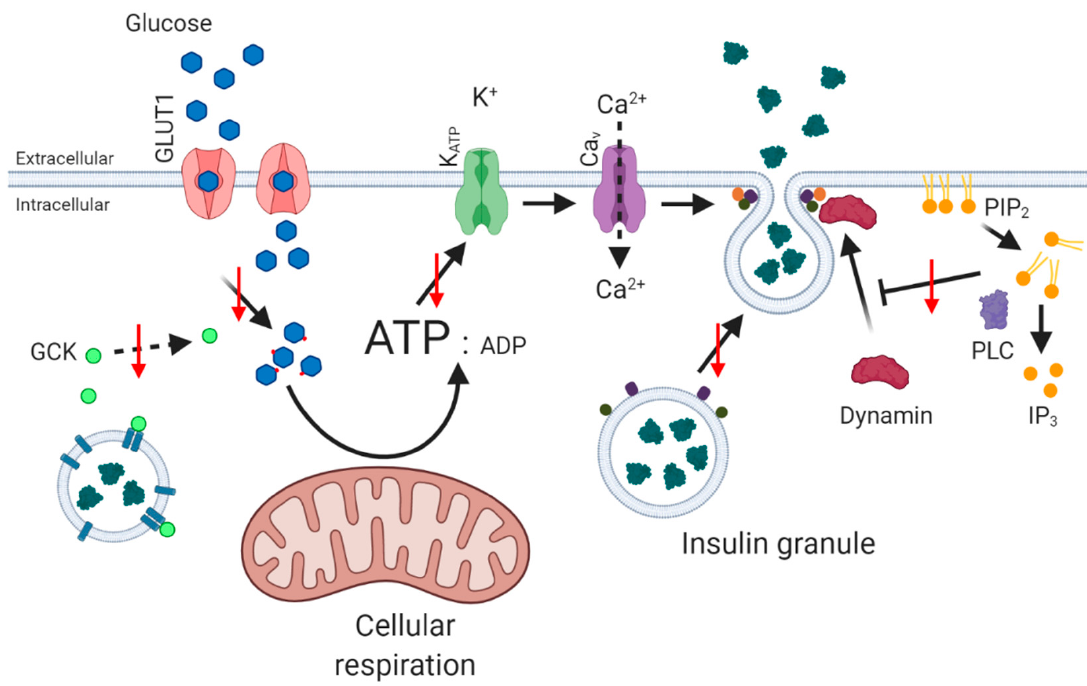
Figure 2. Detrimental effects of cholesterol accumulation on GSIS. High intracellular cholesterol has been shown to negatively affect GSIS through many processes including decreased glucose transporter activity, reduced active GCK leading to decreased change in ATP/ADP ratio, less insulin granule fusion partially due to an increased dynamin